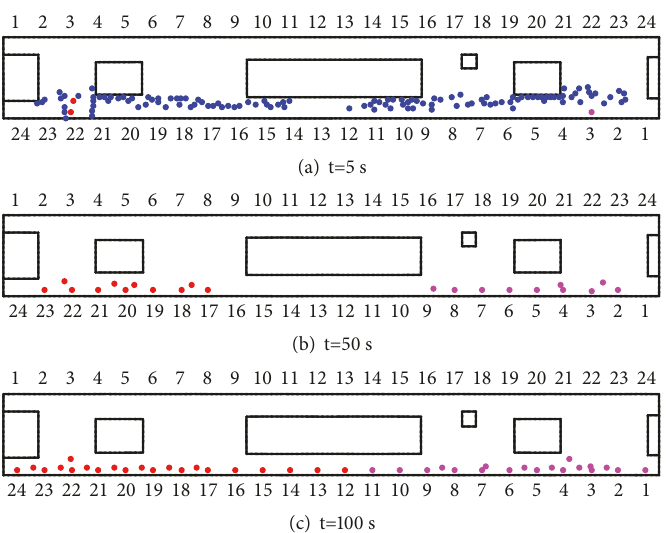
Figure 12: The snapshots of the 2D passenger movement corresponding to a simulation during the model calibration, t=5 s, t=50 s, and t=100 s. Blue dot markers represent alighting passengers and red dot markers represent passengers coming from the left stair/escalator, while magenta dot markers represent passengers coming from the right stair/escalator.